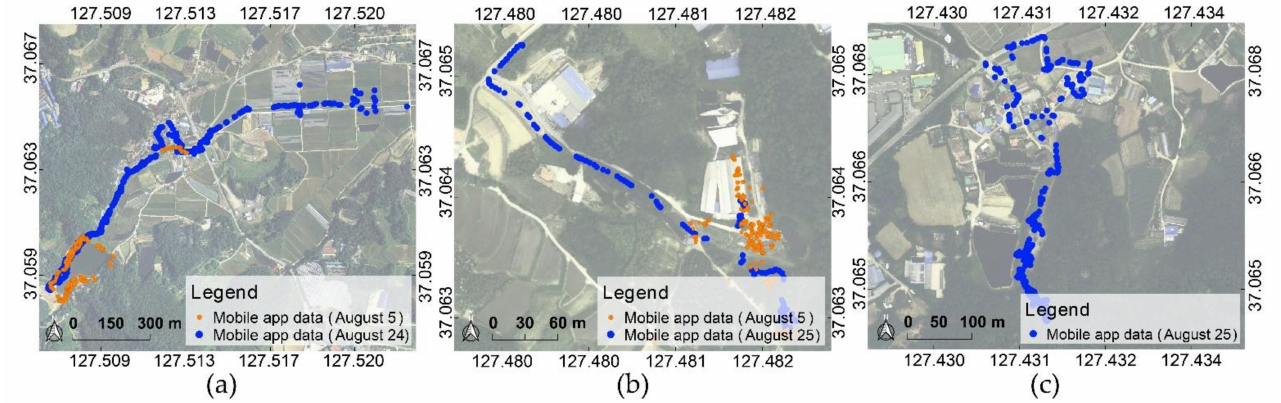
Figure 4. Smartphone application data acquired from study area: ( a ) Yul, ( b ) Iljuk, and ( c ) Juksan. The coordinates refer to WGS84 (EPSG: 4326).